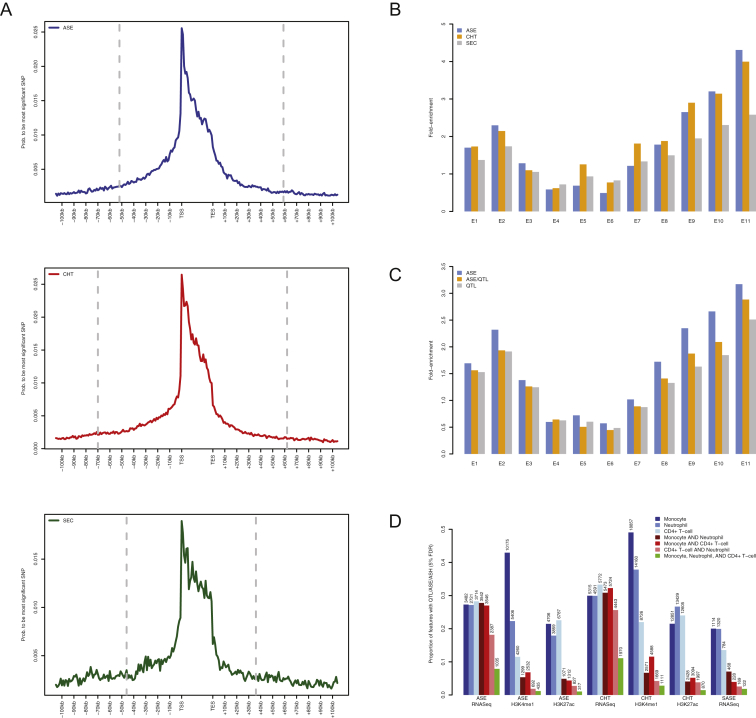
Distribution of Primary ASE Associations, Related to Figures 5 and 6(A) Distribution of primary associations with respect to measured transcript for ASE (Blue), CHT (Red), or secondary, conditional ASE (Green) associations. The relative density of associations is adjusted to tested common SNPs in different bins.(B) Enrichment of chromHMM chromatin states for top primary ASE (Blue), primary CHT (Orange), or secondary ASE (gray) associations. The y axis is the fold-enrichment of SNPs in E1-E11 chromHMM states relative to all SNPs tested for association.(C) Enrichment of chromHMM chromatin states for primary ASE associations (Blue), top primary associations overlapping from ASE and QTL tests (Orange), and from QTL tests (gray). The y axis is the fold-enrichment of SNPs in E1-E11 chromHMM states relative to all SNPs tested for association.(D) Proportion of associations versus tested traits. For each type of test (ASE/CHE/ASES) and assay (Gene, H3K27ac, H3K4me1), the proportion of features with a QTL/ASE/ASH at 5% FDR relative to the total number of features tested is shown as bar graph for each cell type alone (Blue shade), common to two cell types (Red shade), and common all three cell types (green). The actual number of features at 5% FDR is shown above each bar.